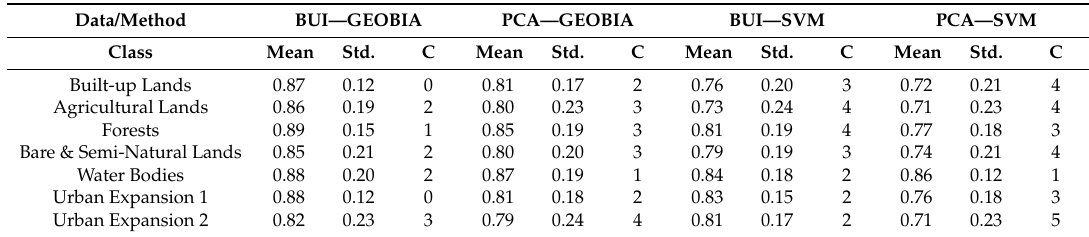
Table 5. Polygon-based accuracy results (Mean: Mean value of Aint/Aref; Std: Standard deviation of Aint/Aref; C: Count for Aint/Aref ≤ 0.50).